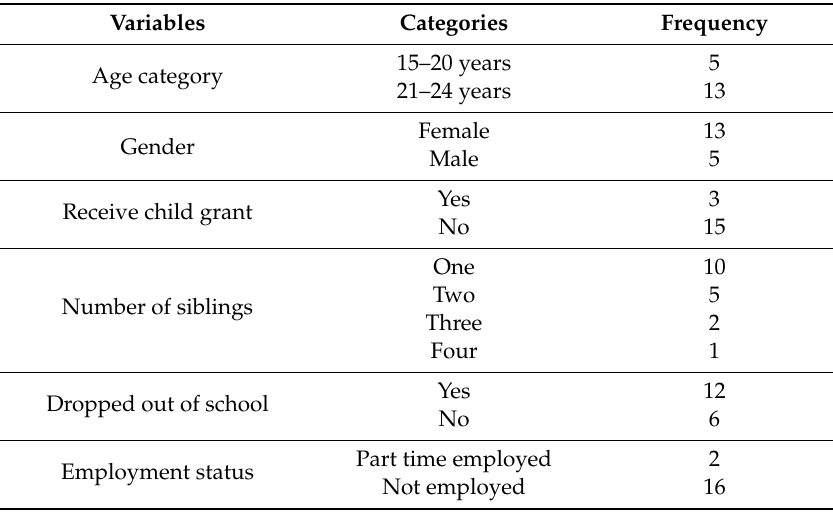
Table 1. Demographic profile of the study